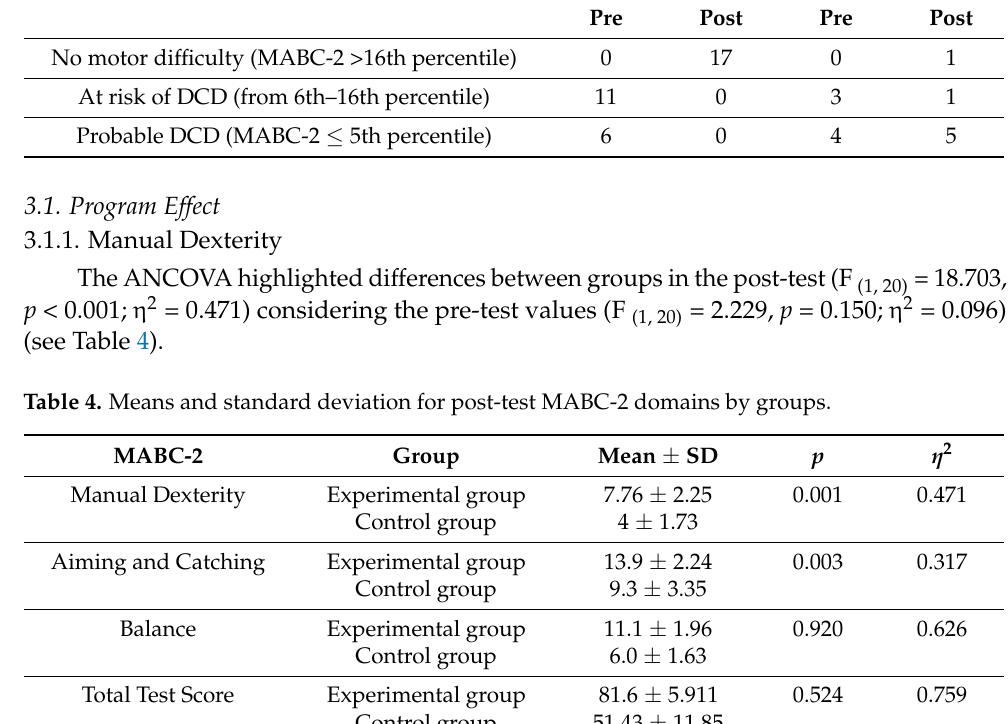
Table 3. Number of children scoring in each MABC-2 percentile band at pre- and post-intervention. Motor Difficulty Category, n